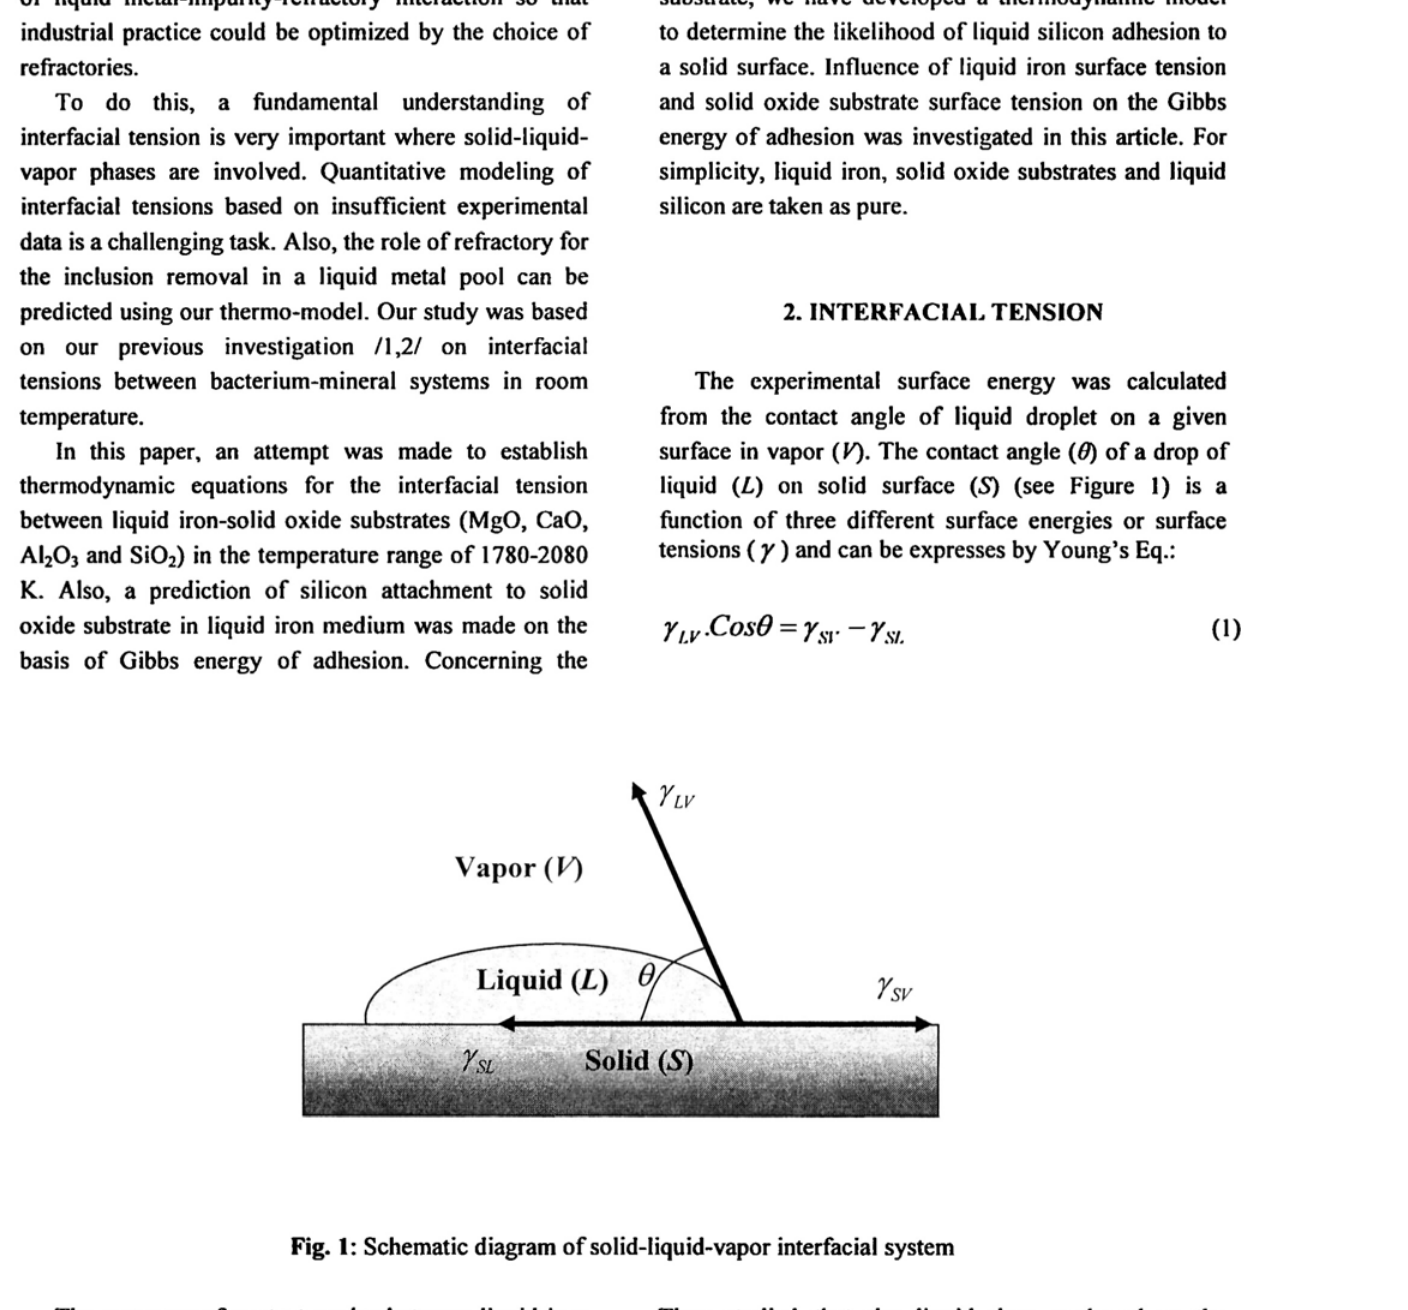
Fig. 1: Schematic diagram of solid-liquid-vapor interfacial system The summary of contact angles between liquid iron and different solid oxide substrates at